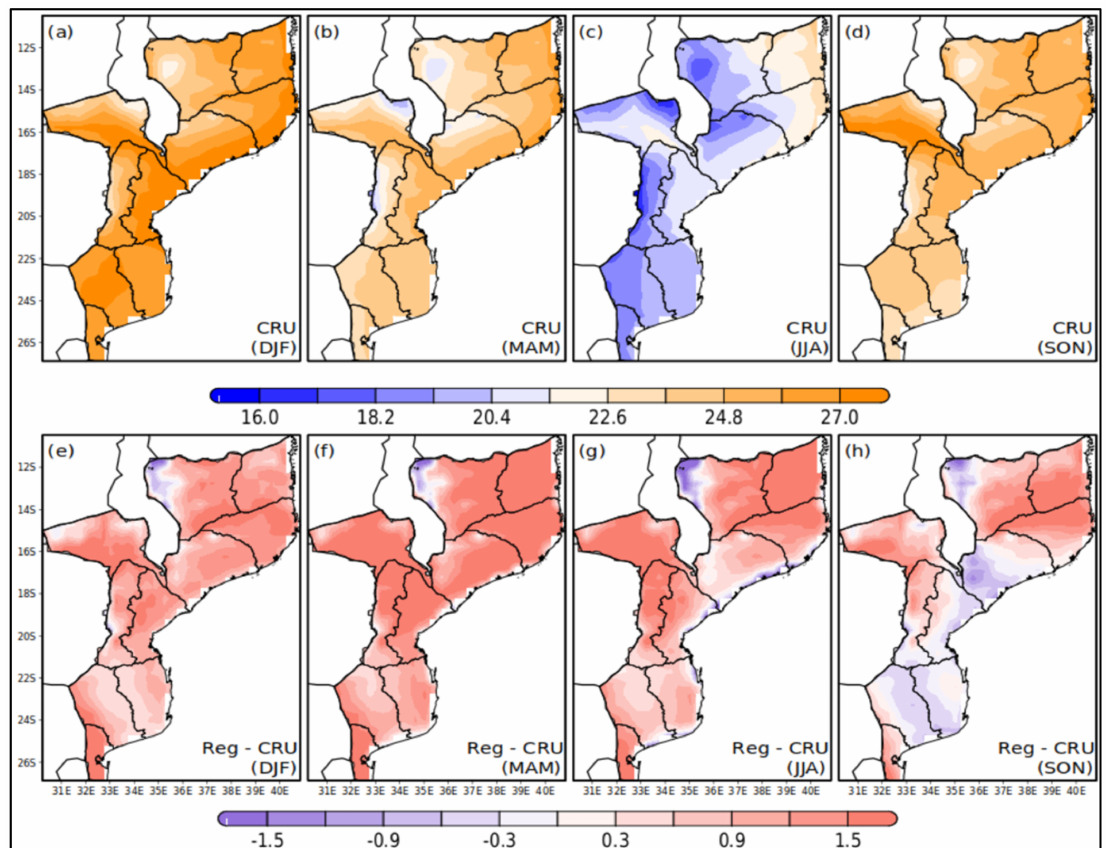
Figure 7. Spatial distribution of seasonal mean air temperature ( ◦ C) obtained from CRU reanaly- sis (upper panels) and difference between simulated RegCM4 and CRU, for the reference period (1971–2000). DJF, MAM, JJA, SON represent the set of 3 months of each climatological